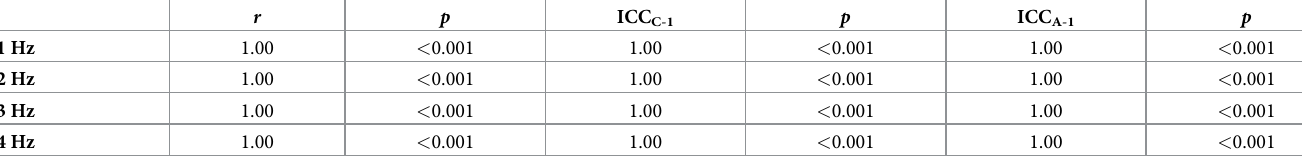
Table 4. Statistical results for correlational analyses of pose estimation vs. manual identification of toe tapping.